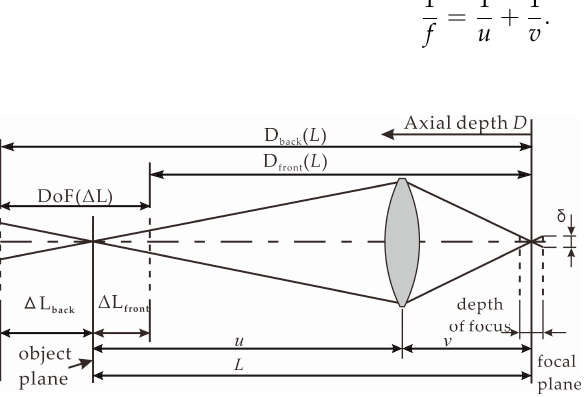
Figure 1. Degree-of-freedom principal diagram.